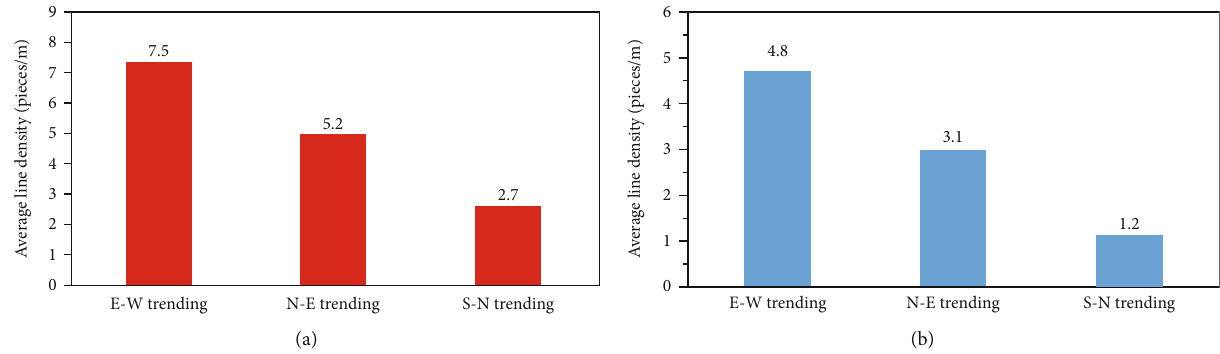
Figure 5: Shale fracture density distribution map in the target layer, i.e., Longmaxi Formation (a) and Niutitang Formation (b), of southeastern